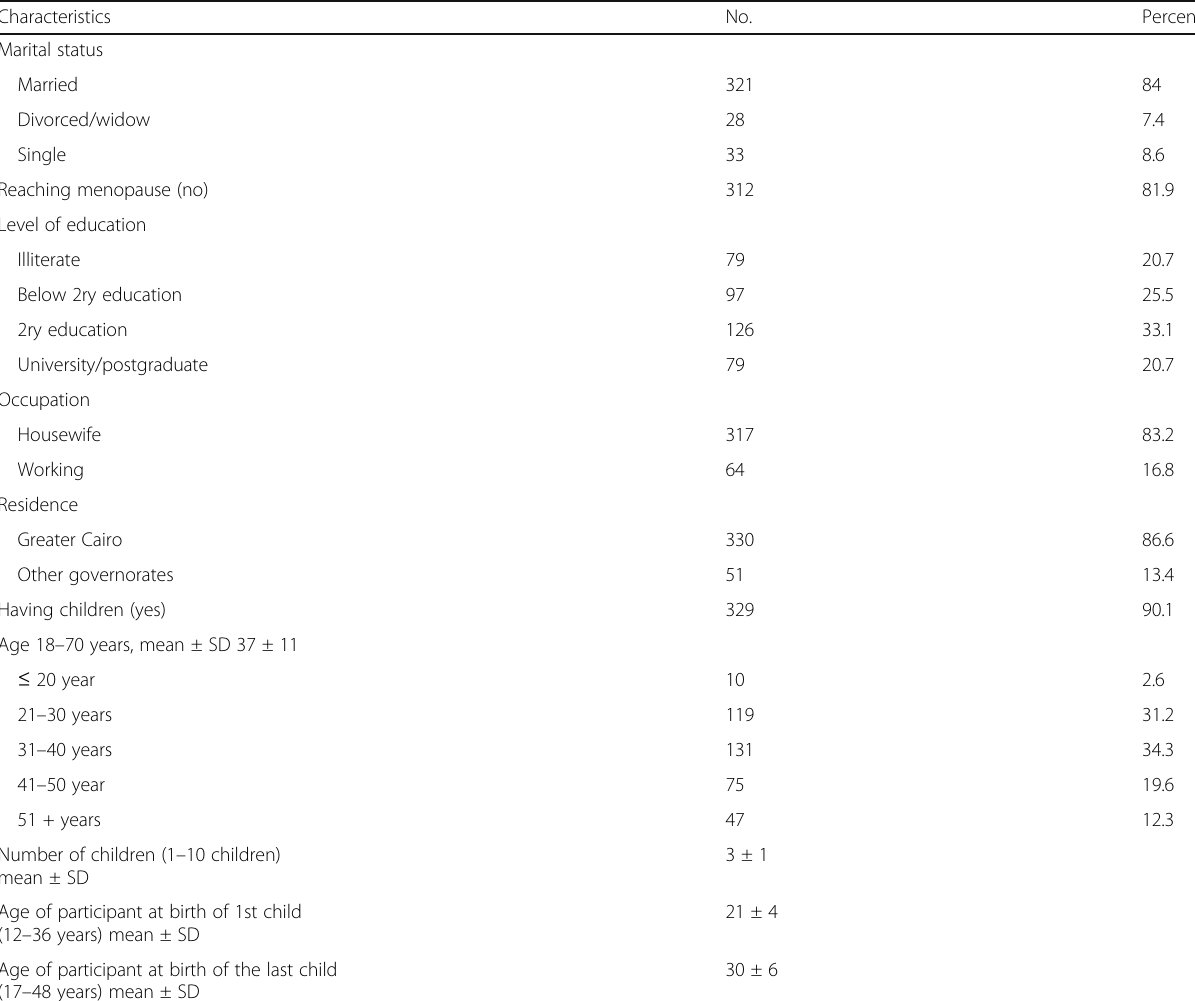
Table 1 Sociodemographic characteristics of study participants, Ain Shams University hospital, outpatient clinics, Egypt, 2017